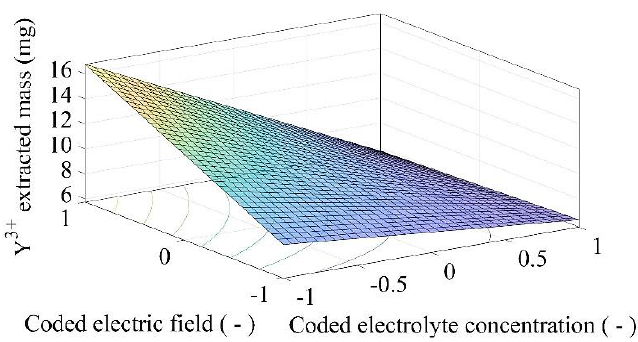
Appl. Sci. 2021 , 11 , x FOR PEER REVIEW Figure 4. Extracted mass function considering the coded design variables. Figure 4. Extracted mass function considering the coded design variables.